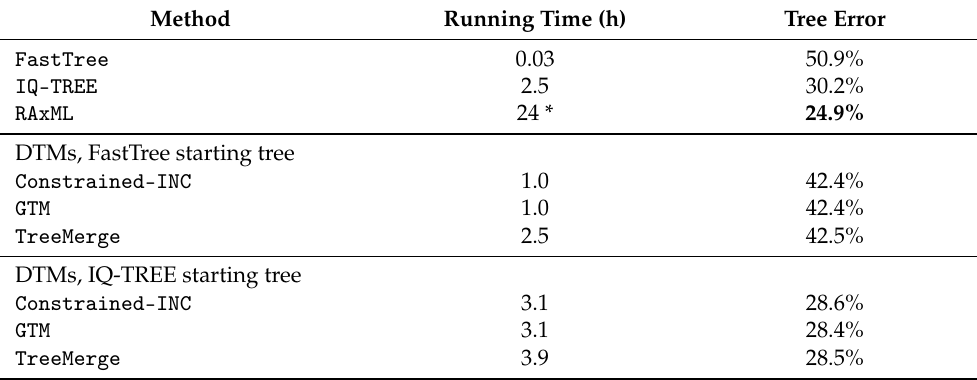
Table 5. Results on the 1000M1-HF datasets. The tree error rates (FN) and running time for existing ML methods and DTM pipelines on the 1000M1-HF model condition (averaged across five replicates). The DTM pipelines use the starting tree as a guide tree with two options for guide trees (FastTree or IQ-TREE), and decompose to maximum subset size 500. If a pipeline requires a distance matrix, as is the case with Constrained-INC and TreeMerge, the topological distance matrix is obtained from the starting tree. The asterisk (*) for RAxML running time indicates that it had not completed by that time, and we used the best scoring tree that it found in that time period. The most accurate result is boldfaced.